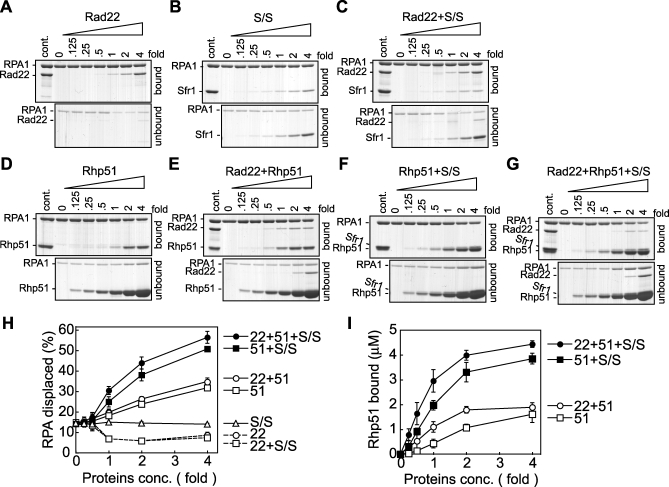
Rhp51 Per Se Is a Factor That Displaces RPA from ssDNA, and the Two Mediators Synergistically Facilitate This ReactionRPA-saturated ssDNA beads were prepared by incubating immobilized ssDNA with RPA (1 μM) and then removing excess RPA by washing the beads with a buffer. Varying concentrations of each protein (Rad22, Rhp51, and Swi5-Sfr1) or protein mixtures were incubated with RPA-saturated ssDNA in the presence of ATP (2 mM) at 37 °C for 30 min. The css beads were pulled down, and the bound and unbound fractions were analyzed by SDS-PAGE. The fold differences in protein concentrations, indicated above each gel, were based on the concentrations used in the standard strand exchange reaction in this study (i.e., “1-fold” corresponds to 5 μM Rhp51, 0.5 μM Swi5-Sfr1, and 0.5 μM Rad22).(A) Rad22 alone.(B) Swi5-Sfr1 (S/S) alone.(C) Rad22 plus Swi5-Sfr1.(D) Rhp51 alone.(E) Rhp51 plus Rad22.(F) Rhp51 plus Swi5-Sfr1.(G) Rhp51 plus Rad22 plus Swi5-Sfr1.(H) The graph shows the relative amounts of RPA (%) in the unbound fractions. Input RPA (bound + unbound) in the “0-fold sample” was normalized to 100%.(I) The graph shows the amounts of Rhp51 (in micromoles) in the bound fractions. The amount of Rhp51 in the bound fractions was estimated from lanes loaded with 2 μM Rhp51 as a standard. The values and error bars in the graphs are average percentages and s.d., respectively, obtained from three independent experiments. 22, Rad22; 51, Rhp51.